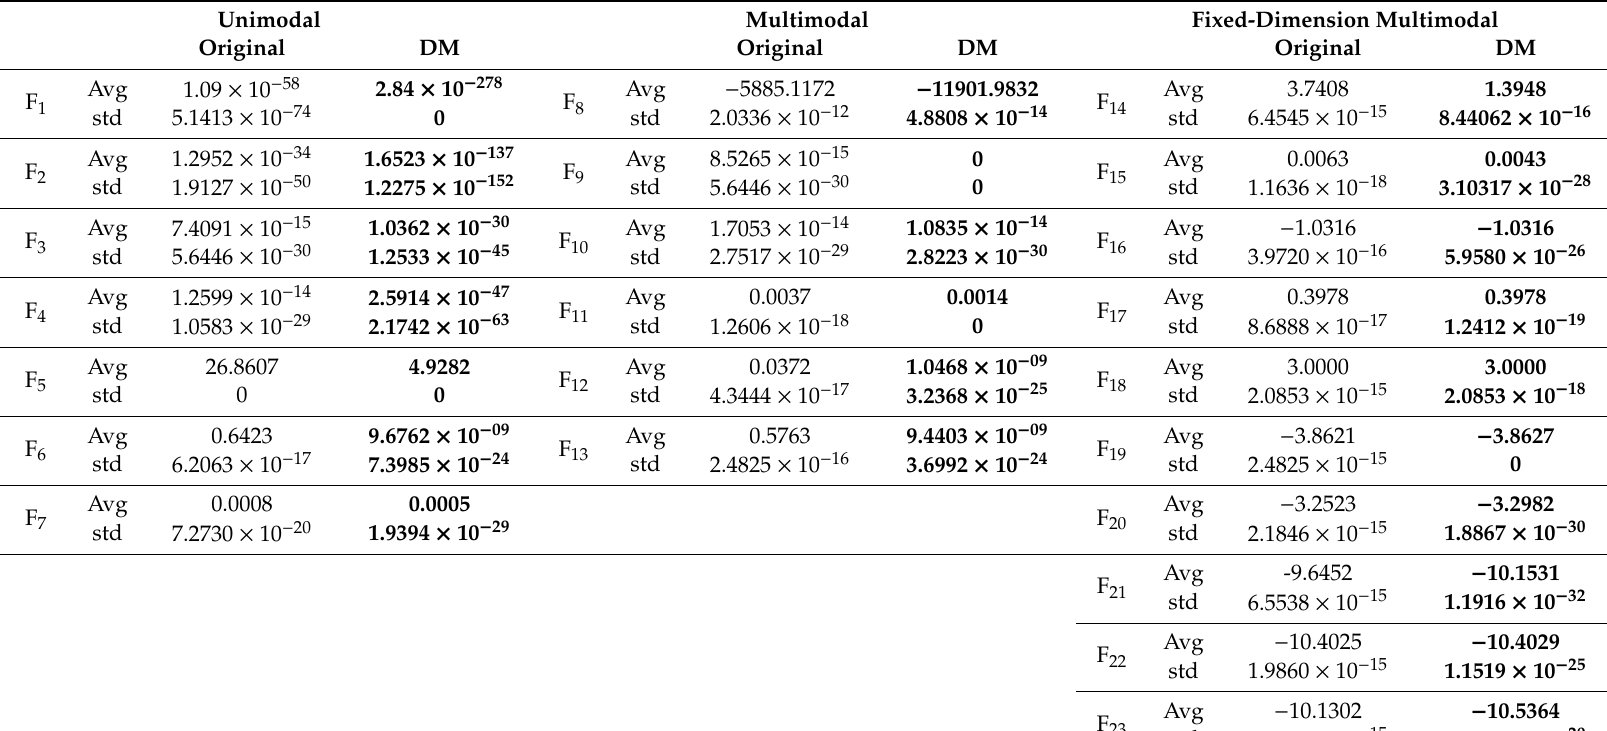
Table 6. Optimization results of grey wolf optimization (GWO) for original and “modified by DM”